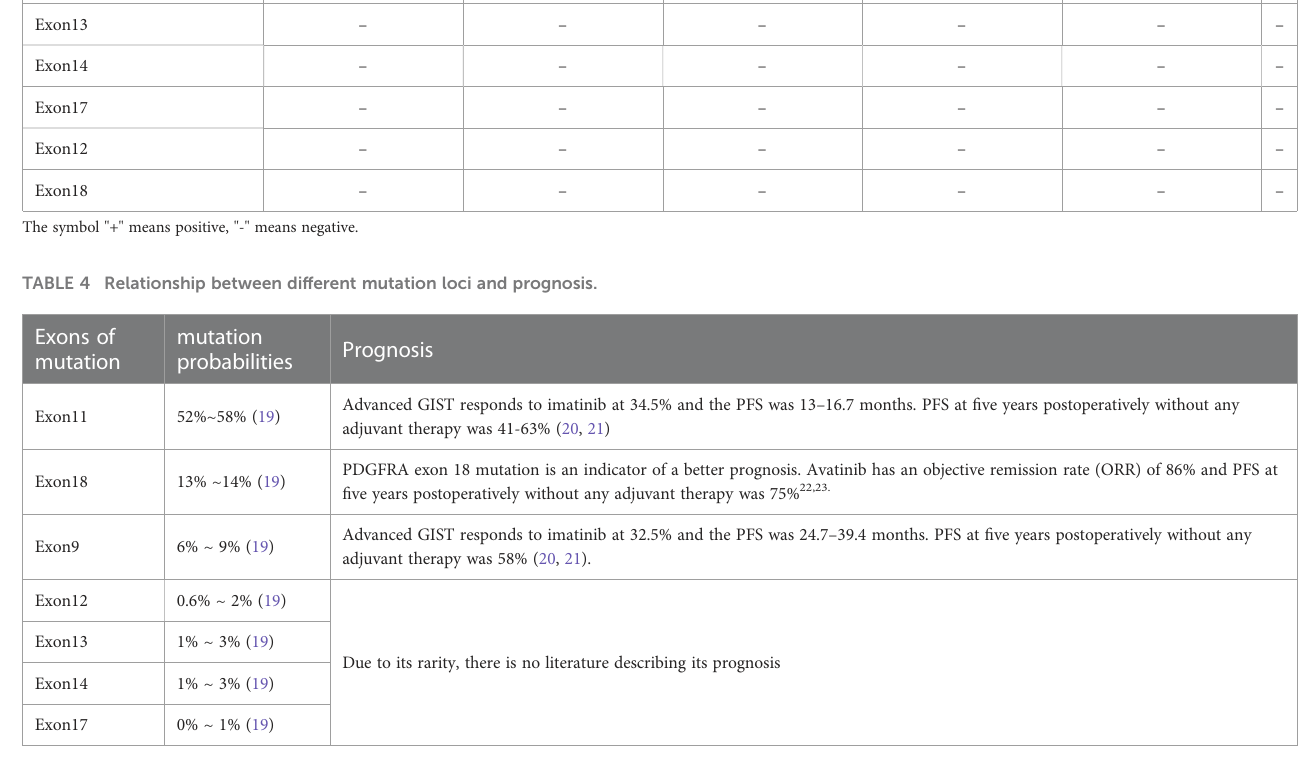
TABLE 3 Kit g and PDGFRA gene mutation features of six patients with retroperitoneal EGISTs. Case